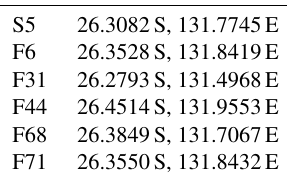
Table C1. Summary of coordinates (WGS 84) of sample locations discussed in the